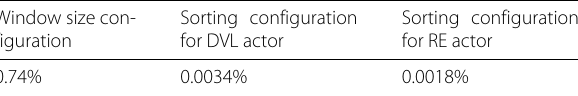
Table 2 Throughput speedup for TRT, RRE, and LFT actors Actor Window size Baseline Optimized (samples) throughput throughput